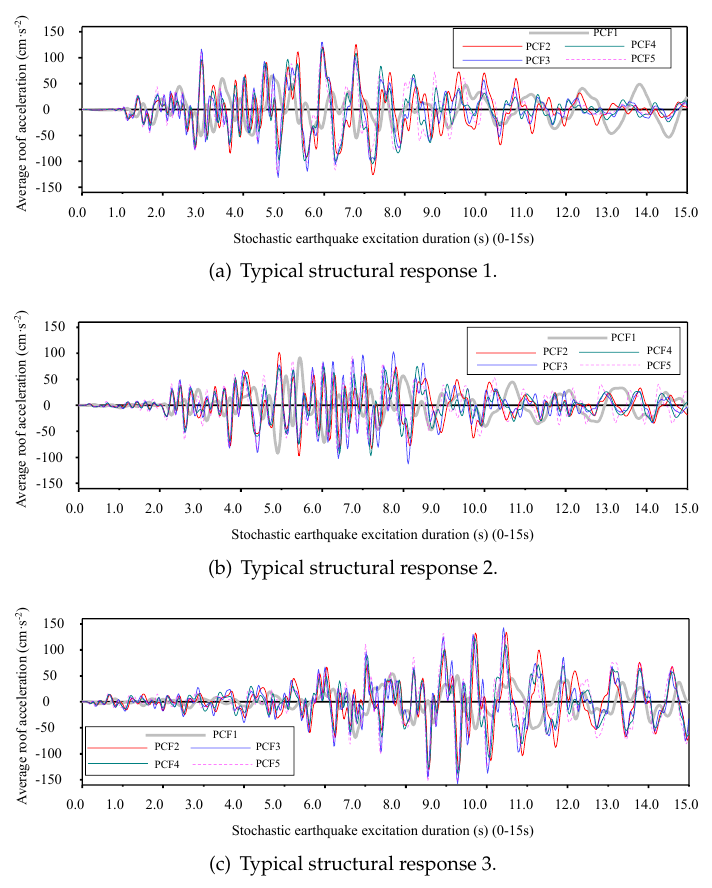
Figure 8. Average roof accelerations of the five PCFs under three typical stochastic nonstation- ary